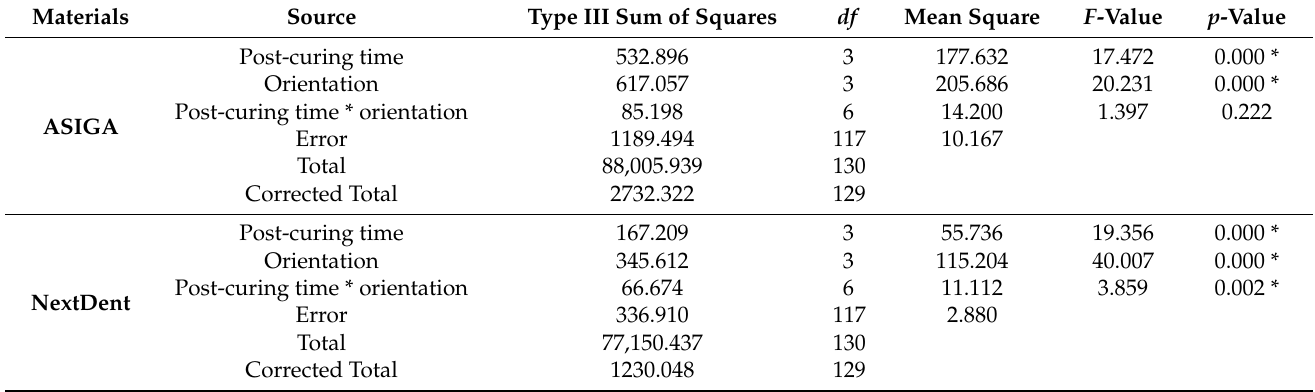
cant mean differences. The combined effect on the surface properties is shown in Table 4.